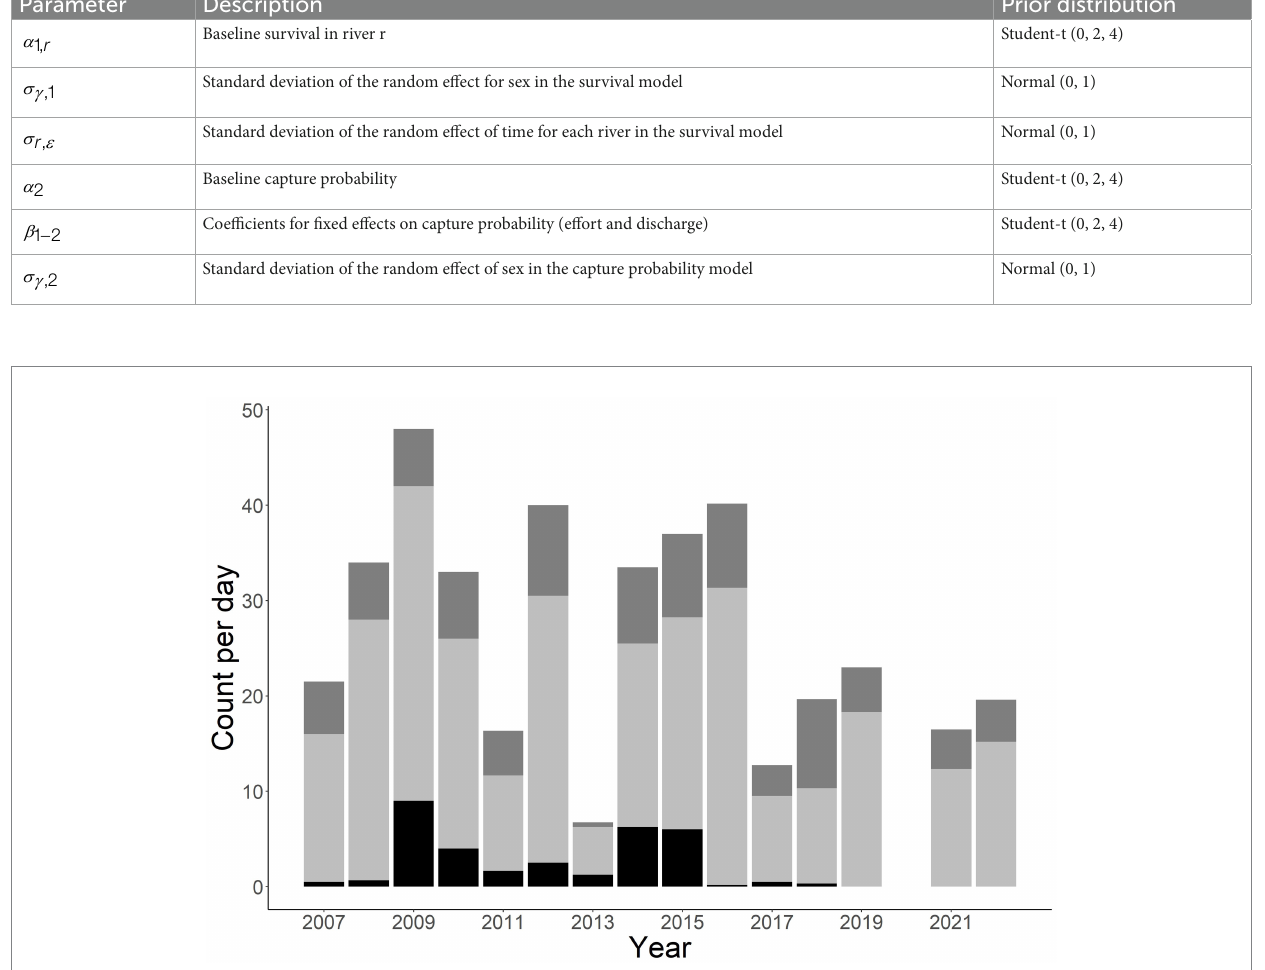
FIGURE 2 Stacked bar chart of total number of Sicklefin Redhorse Moxostoma sp. collected by year in the Little Tennessee River and Tuckasegee River. Dark grey (top of bar) represents total number of females, light grey (middle of bar) represents total number of males, and black (bottom of bar) represents total number of unknown